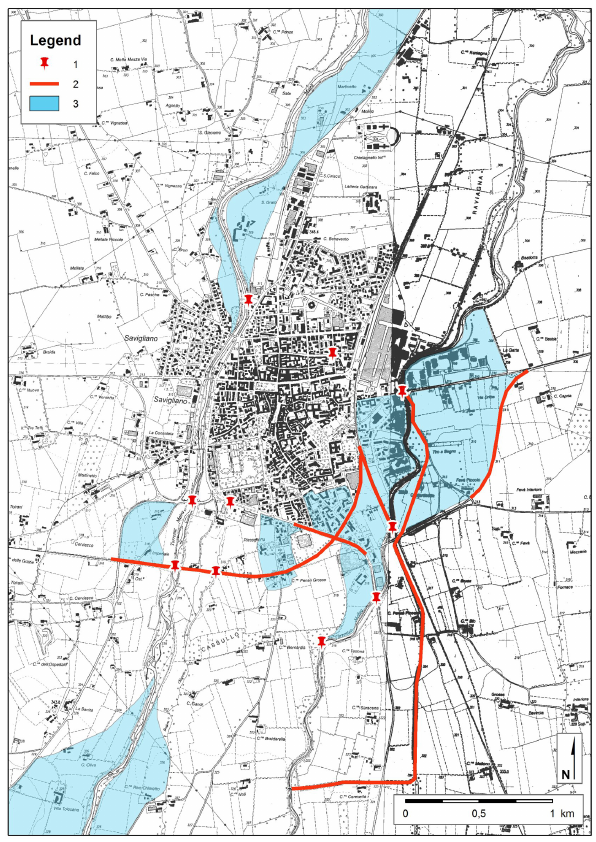
Fig. 8. The most flood-hazard points and flooding-prone areas around the city. (1) Possible overflow points; (2) non-natural obsta- cle to water flow (roads, railways) and artificial channels; (3) pos- sible flooded area. In the background the Technical regional map 1991